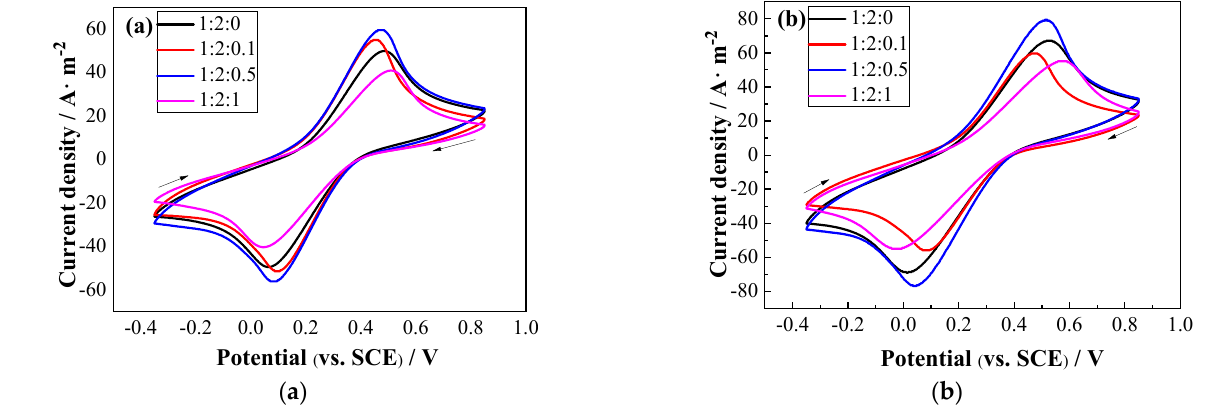
Figure 4. Cyclic voltammogram of the DESs with 0.1 mol·L − 1 FeCl 3 ·6H 2 O at the scan rates of ( a ) 50 mV·s − 1 ; ( b )100 mV·s − 1 .